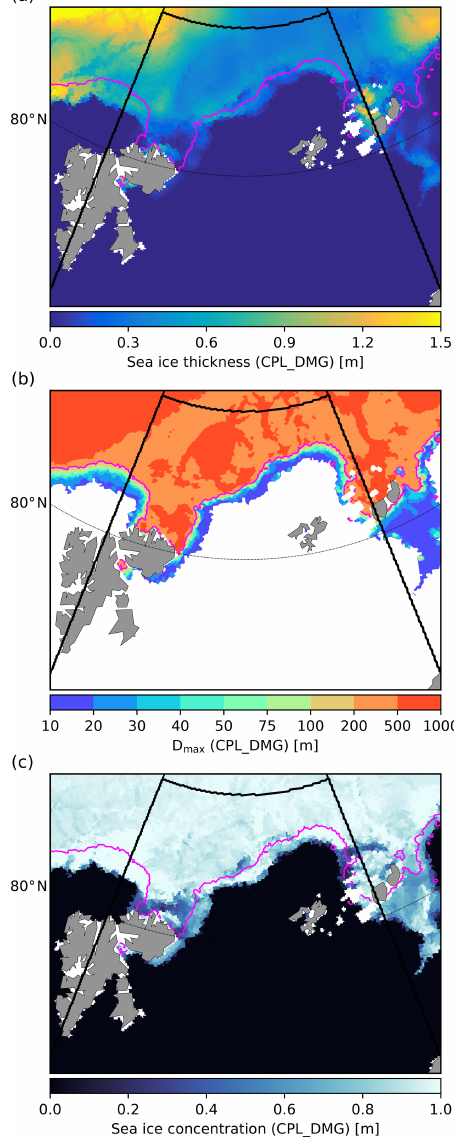
Figure 8. Distributions of sea ice thickness (a) , maximum floe size (b) and sea ice concentration (c) from the CPL_DMG simu- lation in the Barents Sea on 15 October 2015 at 00:00:00. The ma- genta line corresponds to the contour D max = 200m in CPL_DMG. The black thick lines delimit the domain used to analyse the re- sults from the three simulations (REF, CPL_WRS, CPL_DMG) in Figs. 9, 12 and